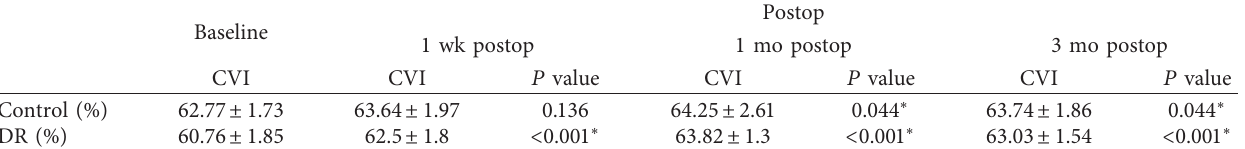
Table 2: CVI of the patients with mild/moderate NPDR (DR) and nondiabetic patients (control) at four visits (mean ± SD).